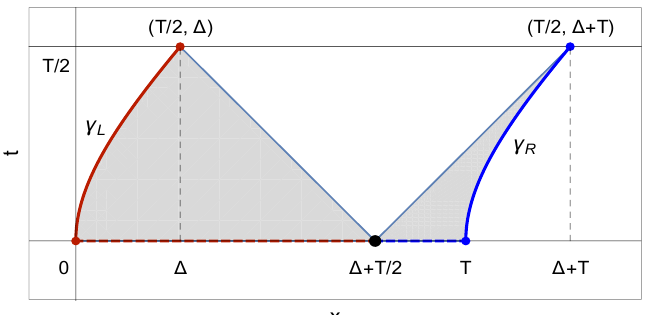
Figure 36 . Borders (cid:13) L and (cid:13) R of the oscillon and the supports [0 ; (cid:1) + T= 2] and [(cid:1) + T= 2 ; T ] of f ( x